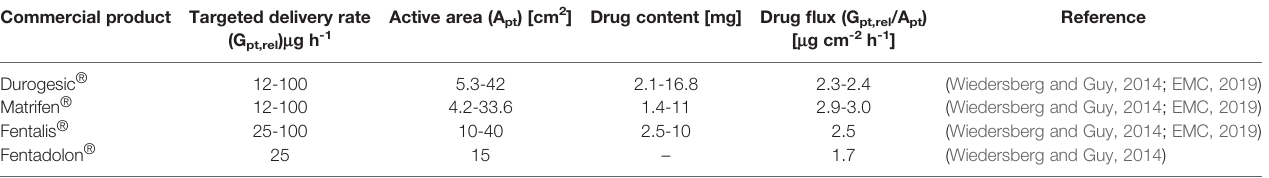
The fl ux was deduced from the labeled delivery rate and active area of the patch through which the drug is